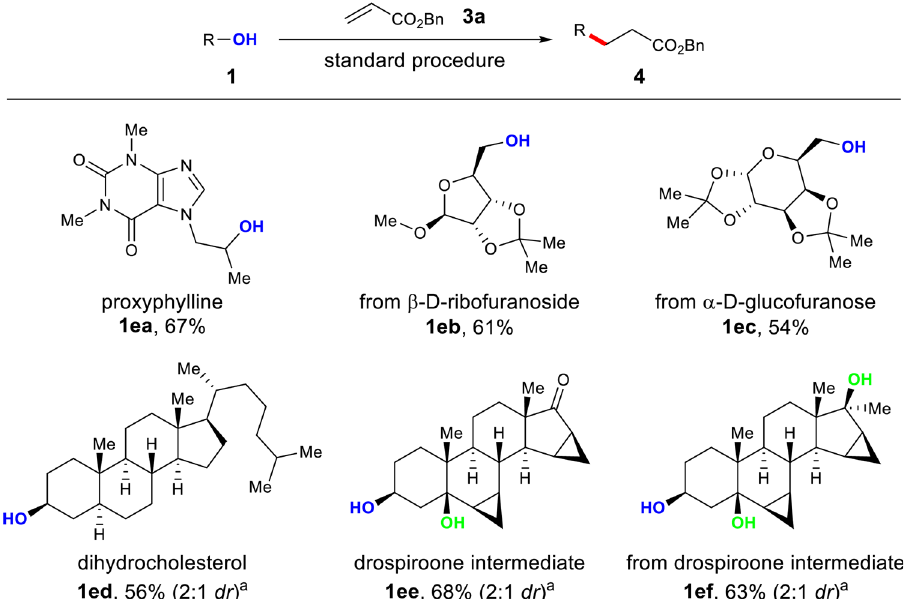
Fig. 6 Synthetic applications of the methodology. The standard procedure is as shown in Table 1. Isolated yields are reported. a The dr was determined by 1 H NMR analysis of the product after fl ash